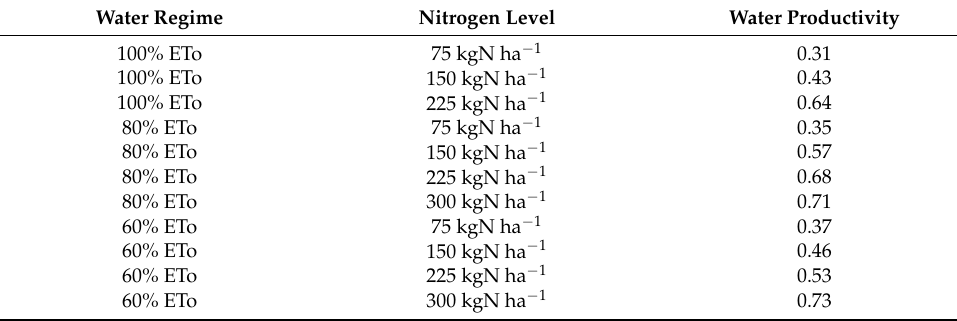
Figure 6. Path analysis diagram showing the interrelationships between seed yield (response variable) and other studied traits under four nitrogen levels of 75 ( A ), 150 ( B ), 225 ( C ), and 300 kgN ha − 1 ( D ). Bidirectional arrows show the correlation between the variables and single-headed arrows indicate direct path coefficients; green and red arrows represent positive and negative effects, respectively. Solid arrows indicate p < 0.05. PH: plant height (cm); EL: panicle length (cm); DW: dry weight (g); Table 6. Water productivity during different water regimes and nitrogen